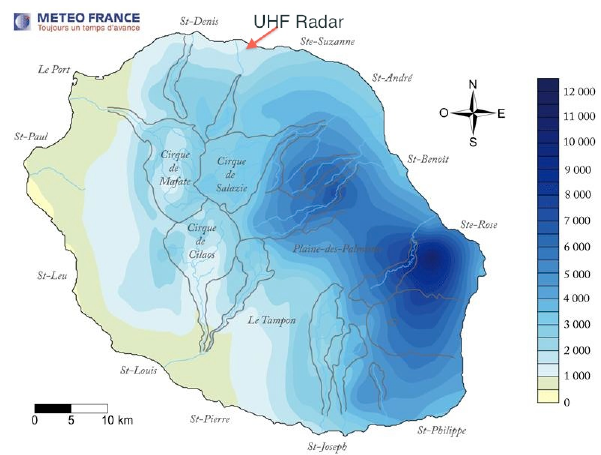
Figure 2. Mean annual rainfall (mm) in Réunion island over a 20-year period starting in 1981. 636 Fig. 2. Mean annual rainfall (mm) on Réunion over a 20yr period Precipitation estimates are derived from rain gauge data deployed throughout the island. 637 starting in 1981. Precipitation estimates are derived from rain gauge data taken throughout the